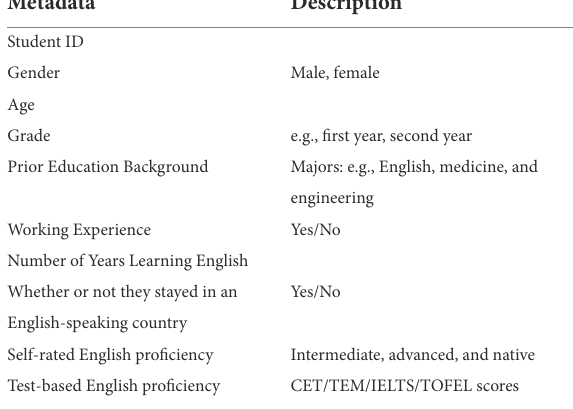
TABLE 3 Metadata for students.